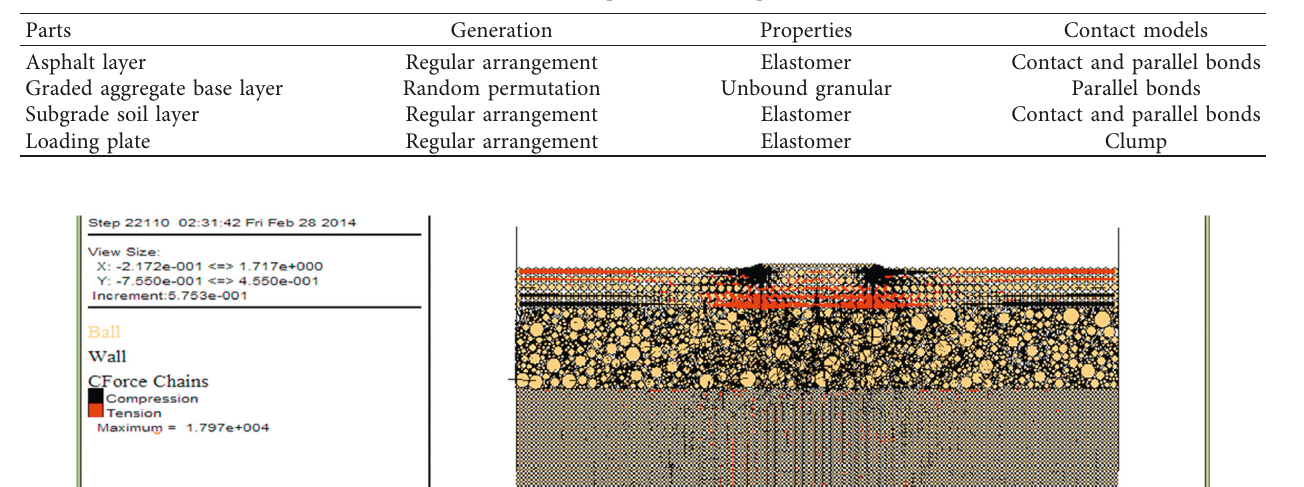
Table 2: Properties for each part.